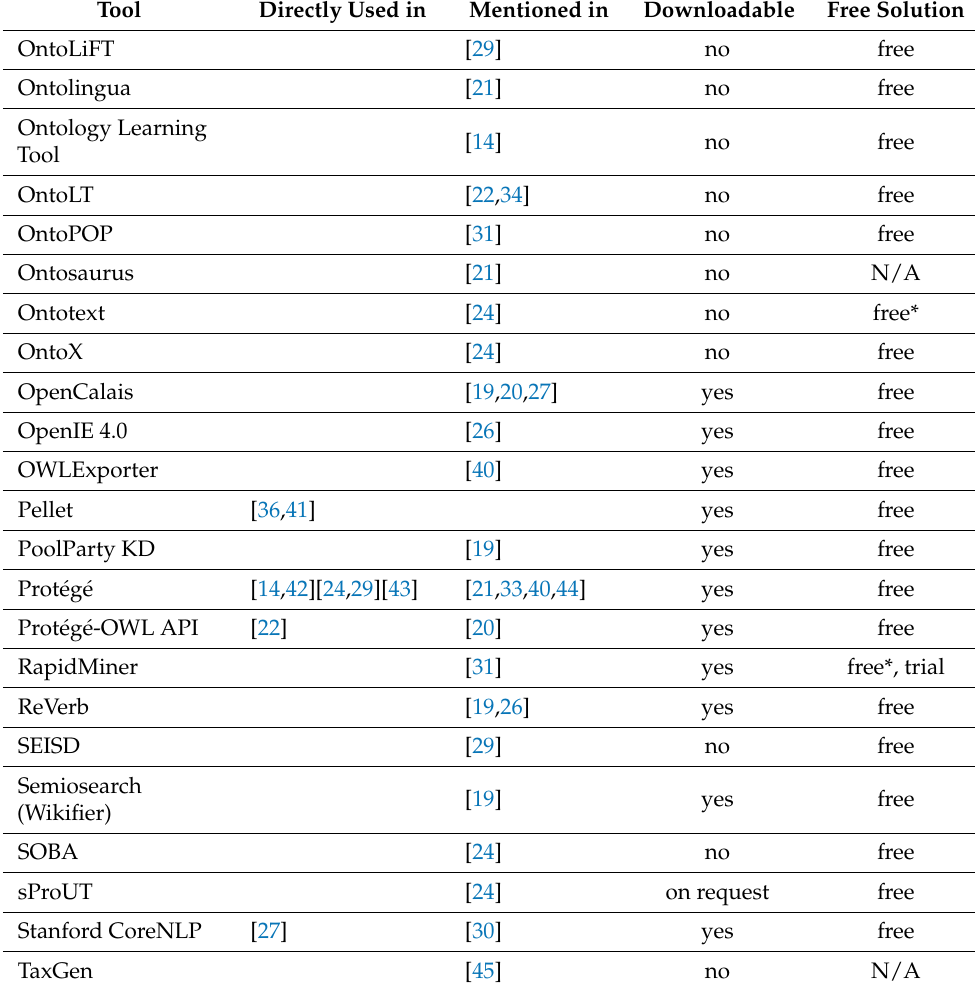
Table 5. Selected characteristics of the tool (tools 36–73). Tool Directly Used in Mentioned in OntoLiFT Ontolingua Ontology Learning Tool